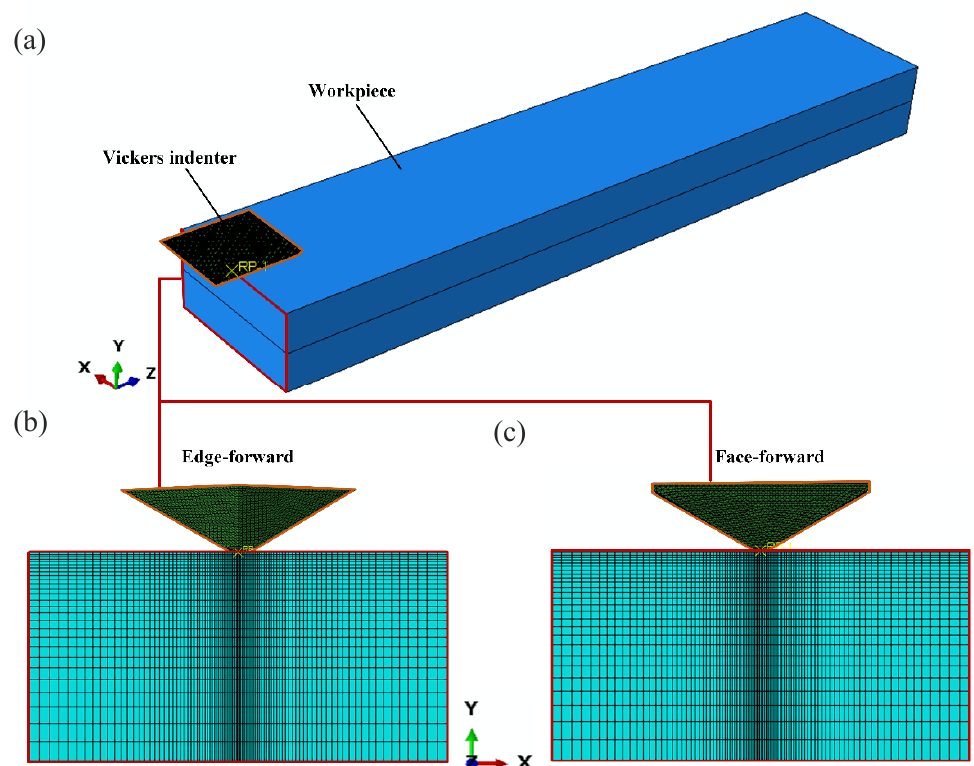
Figure 10. The three-dimensional finite element model. ( a ) the three-dimensional FEM; ( b ) the side view of edge-forward; ( c ) the side view of face-forward.